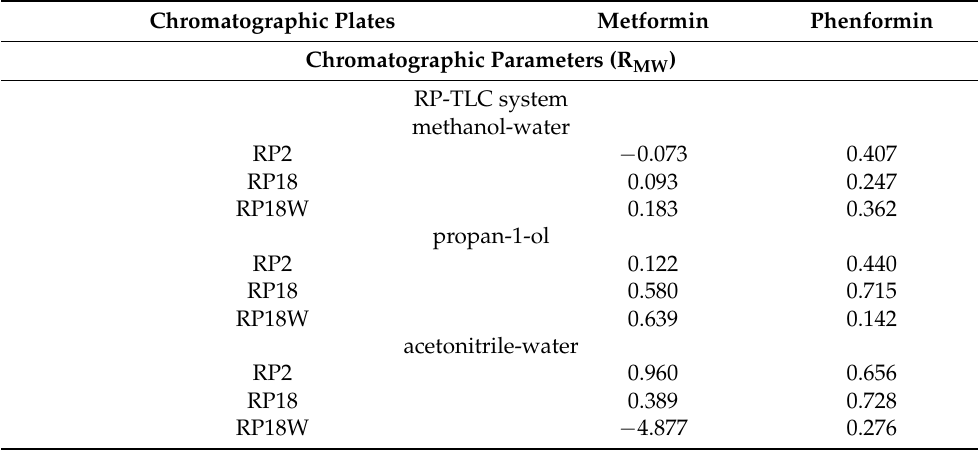
Table 2. Comparison of R MW values obtained with the use of different stationary phases in the RP-TLC and NP-TLC